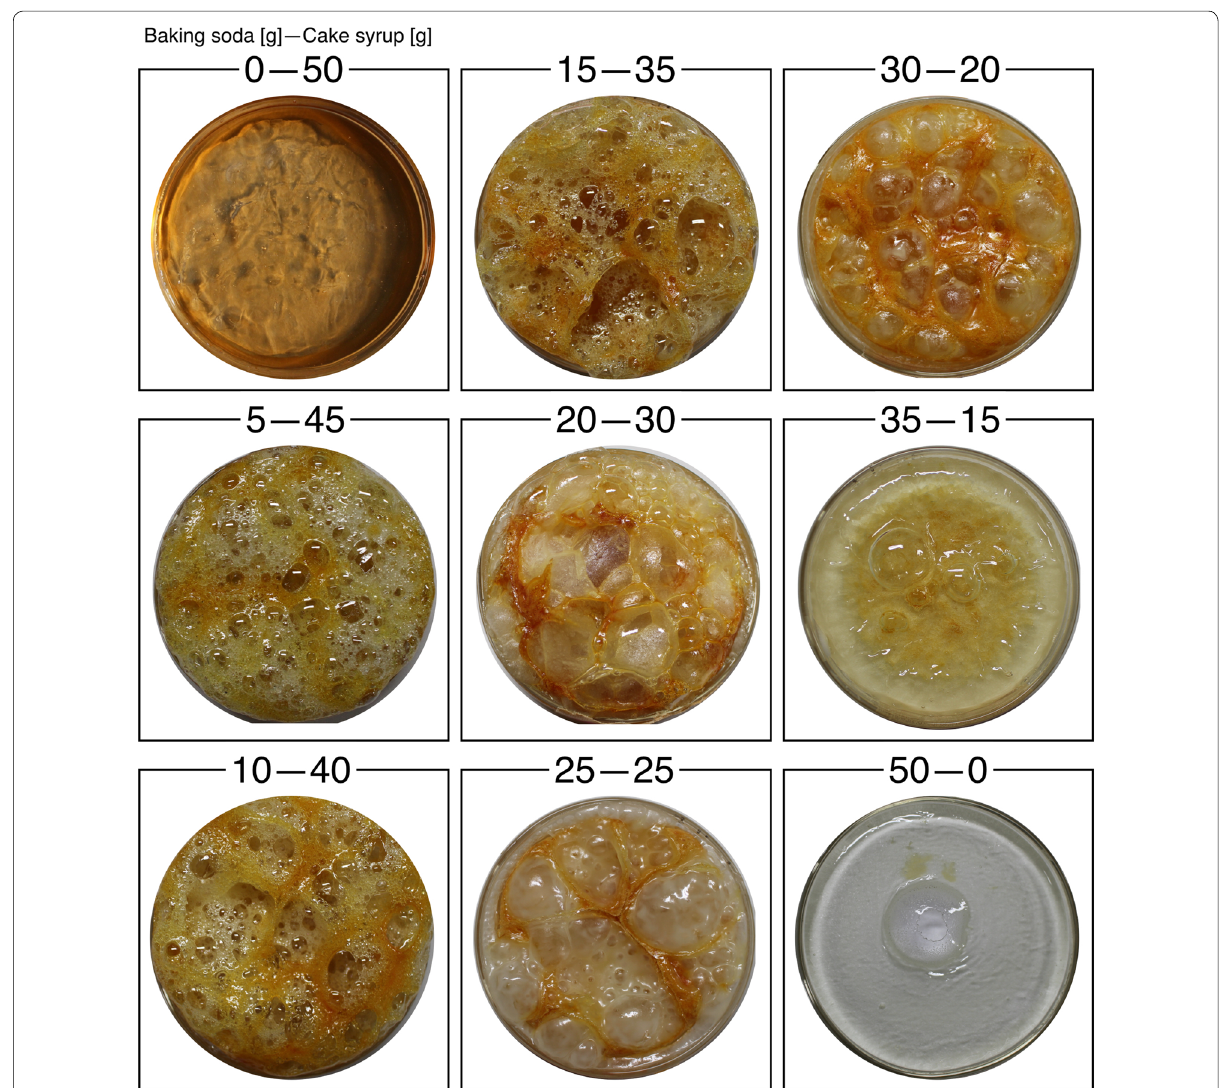
Fig. 2 Final surface morphology for each substrate composition. Detailed photographs are shown in Additional file 1: Figs. S3–S11 in the supplementary